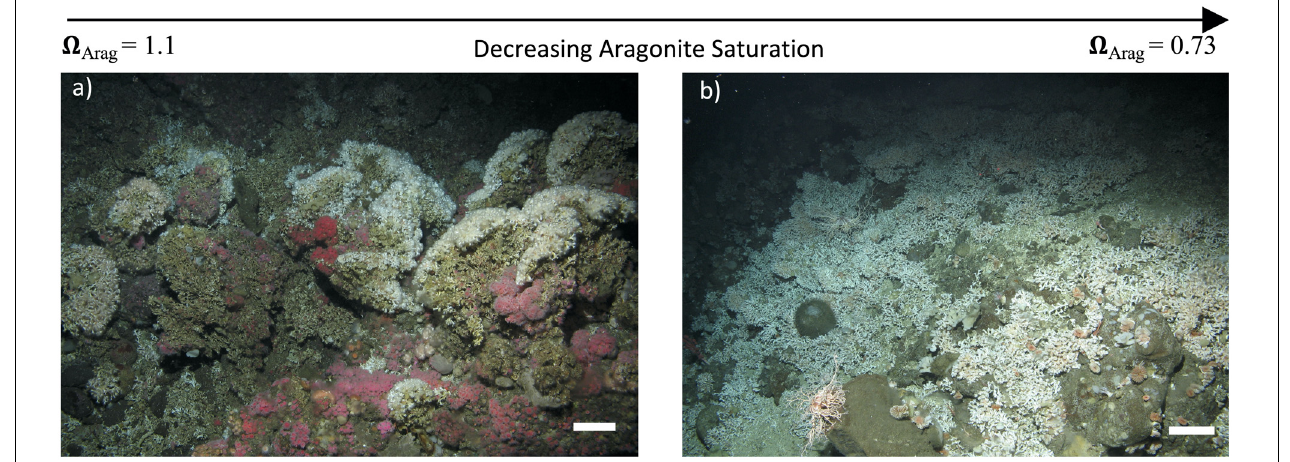
FIGURE 1 | The CWC Lophelia pertusa above and below the ASH in the Southern California Bight. Scale bars are 20 cm. (a) Example image of L. pertusa reef above the ASH, with substantial 3-dimensionally complex cohesive reef framework consisting of live coral (white crowns) and dead coral (brown/grey foundations). (b) Example of live L. pertusa colonies providing low habitat complexity on exposed rock. No dead framework is evident. Aragonite saturation states ( (cid:127) Arag ) are indicated. Image stills in (a,b) were taken alongside ROV footage of sites with further site details in Supplementary Table 1 .